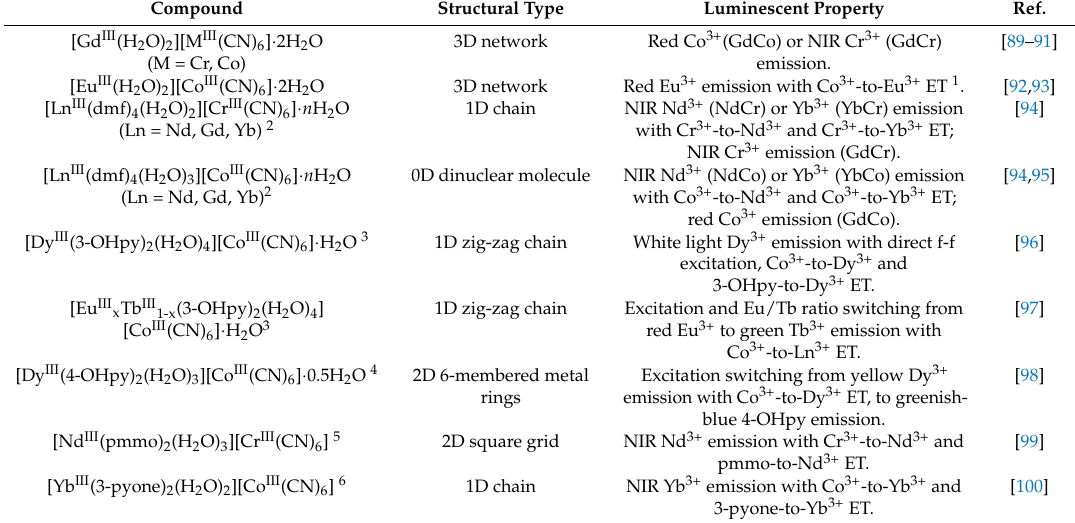
Table 3. Photoluminescent hexacyanidometallate-based compounds containing lanthanide ions.